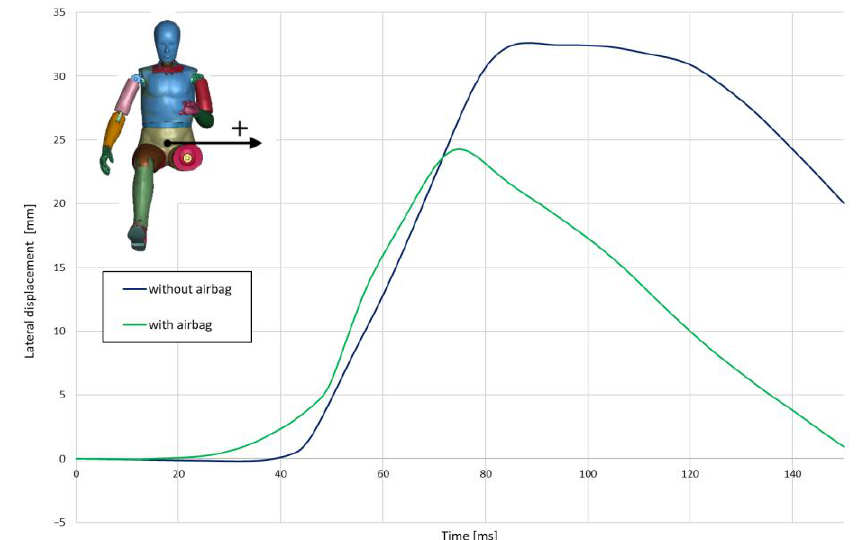
Figure 6. Lateral displacement of H-point.